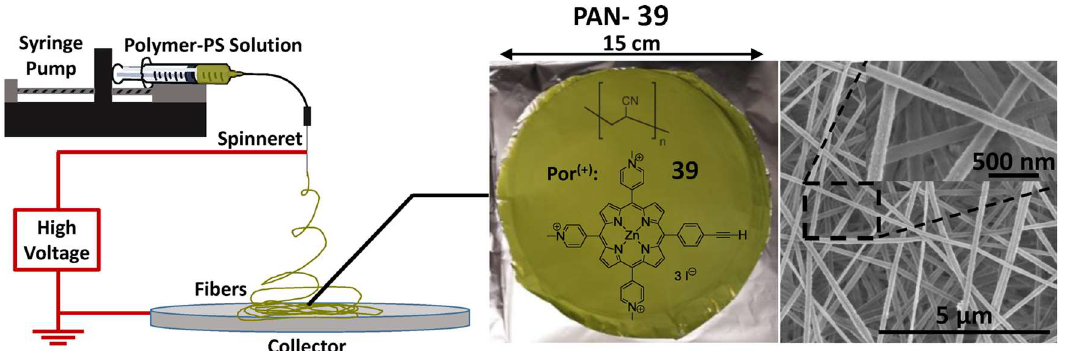
Figure 29. Electrospinning schematic ( left ), PAN- 39 (middle), and scanning electron microscopy (SEM) images ( right ). Reprinted with permission from Ref. [186]. © 2022 Frontiers Media S.A. All rights reserved.